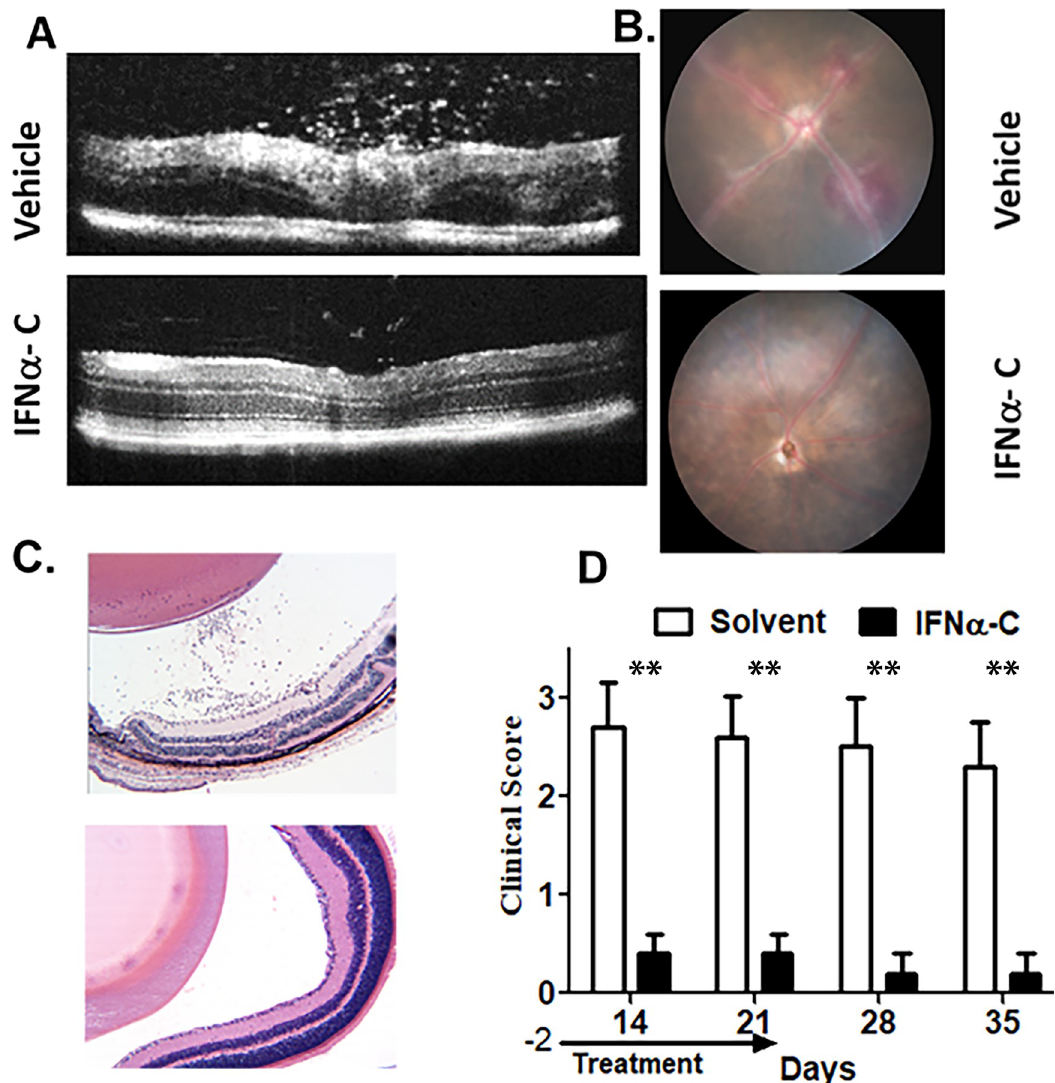
emulsified in complete Freund’s adjuvant. Treatment with IFN α -C or solvent was continued for 3 weeks. A . Optical coherence tomography on day 14. Mice treated with solvent showed influx of inflammatory cells and swelling of retina, which were not seen in mice treated with IFN α -C. B . Fundoscopic images on day 14 show engorged blood vessels and hemorrhage in solvent treated mice. C . Hematoxylin and eosin staining of eyes harvested on day 14 after immunization. Infiltrating cells and retinal folding seen in solvent were not observed in mice treated with IFN α -C. Images were taken at 40x magnification. D . A clinical score, as described in Materials and Methods was used. Mice treated with IFN α -C were protected against the symptoms of EAU. The error bars represent standard deviation. The symptoms did not develop in the following two weeks after termination of treatment. �� , p <